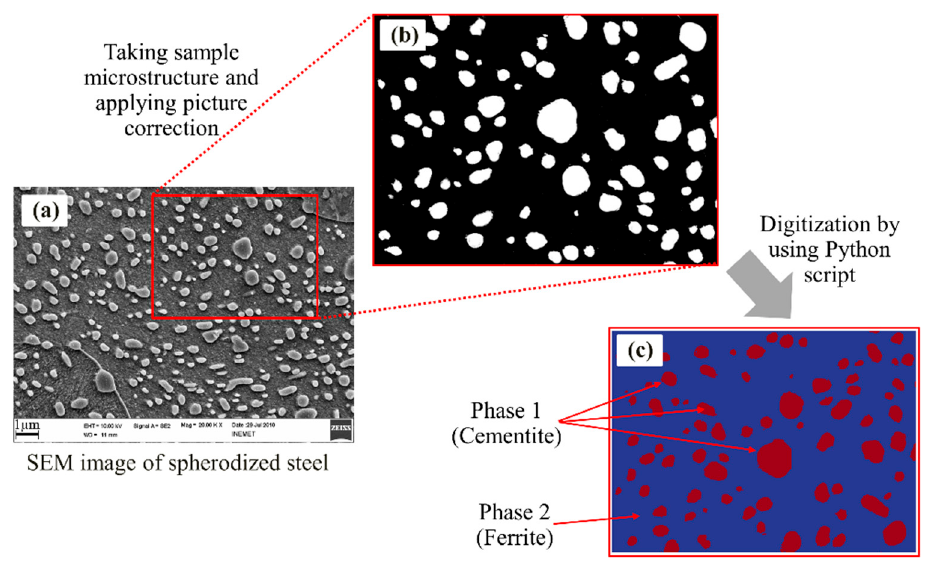
Figure 1. Spheroidized steel microstructure and its digitization into a geometry file for DAMASK simulation: ( a ) scanning electron microscope (SEM) image of spheroidized steel sample at 20 KX; ( b ) cropped 503 p-wide and 365 p-high area of the SEM image; and ( c ) digitized image showing the two-phase data for the Düsseldorf Advanced Material Simulation Kit (DAMASK) input.